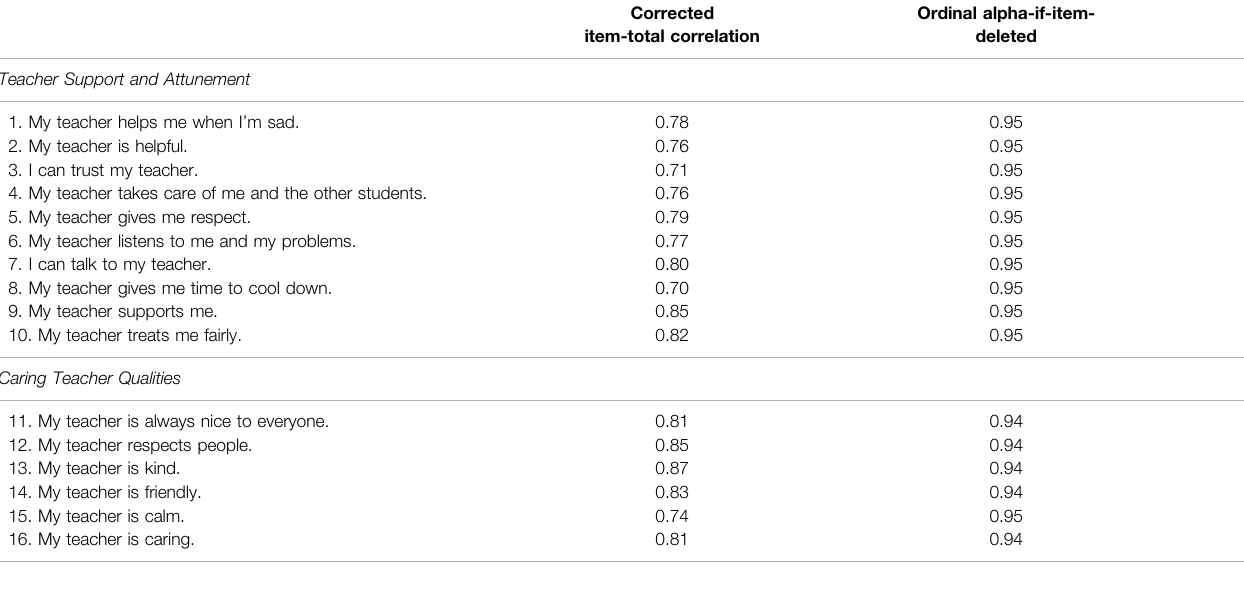
TABLE 5 | Corrected item total correlations, and ordinal alpha-if-item-deleted of items of CSTR.